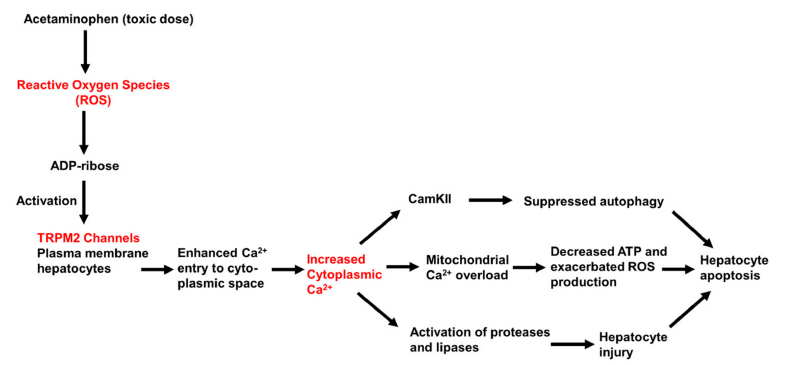
Figure 6. Schematic representation of the proposed role of TRPM2 in mediating liver toxicity caused by high (overdose) levels of acetaminophen. The increase in ROS, resulting from the metabolism of acetaminophen and generation of high levels of NAPQI (Scheme, Figure 5), are proposed to lead to the synthesis of ADP-ribose, activation of TRPM2, Ca 2+ entry to the cytoplasmic space, and increased [Ca 2+ ] cyt . This, in turn, is proposed to lead to mitochondrial Ca 2+ overload, the activation of Ca 2+ -sensitive proteases and lipases, and the activation of Ca 2+ /calmodulin protein kinase II (CamKII) and supressed autophagy. The activation of these pathways eventually leads to cellular apoptosis and death. (References are in the